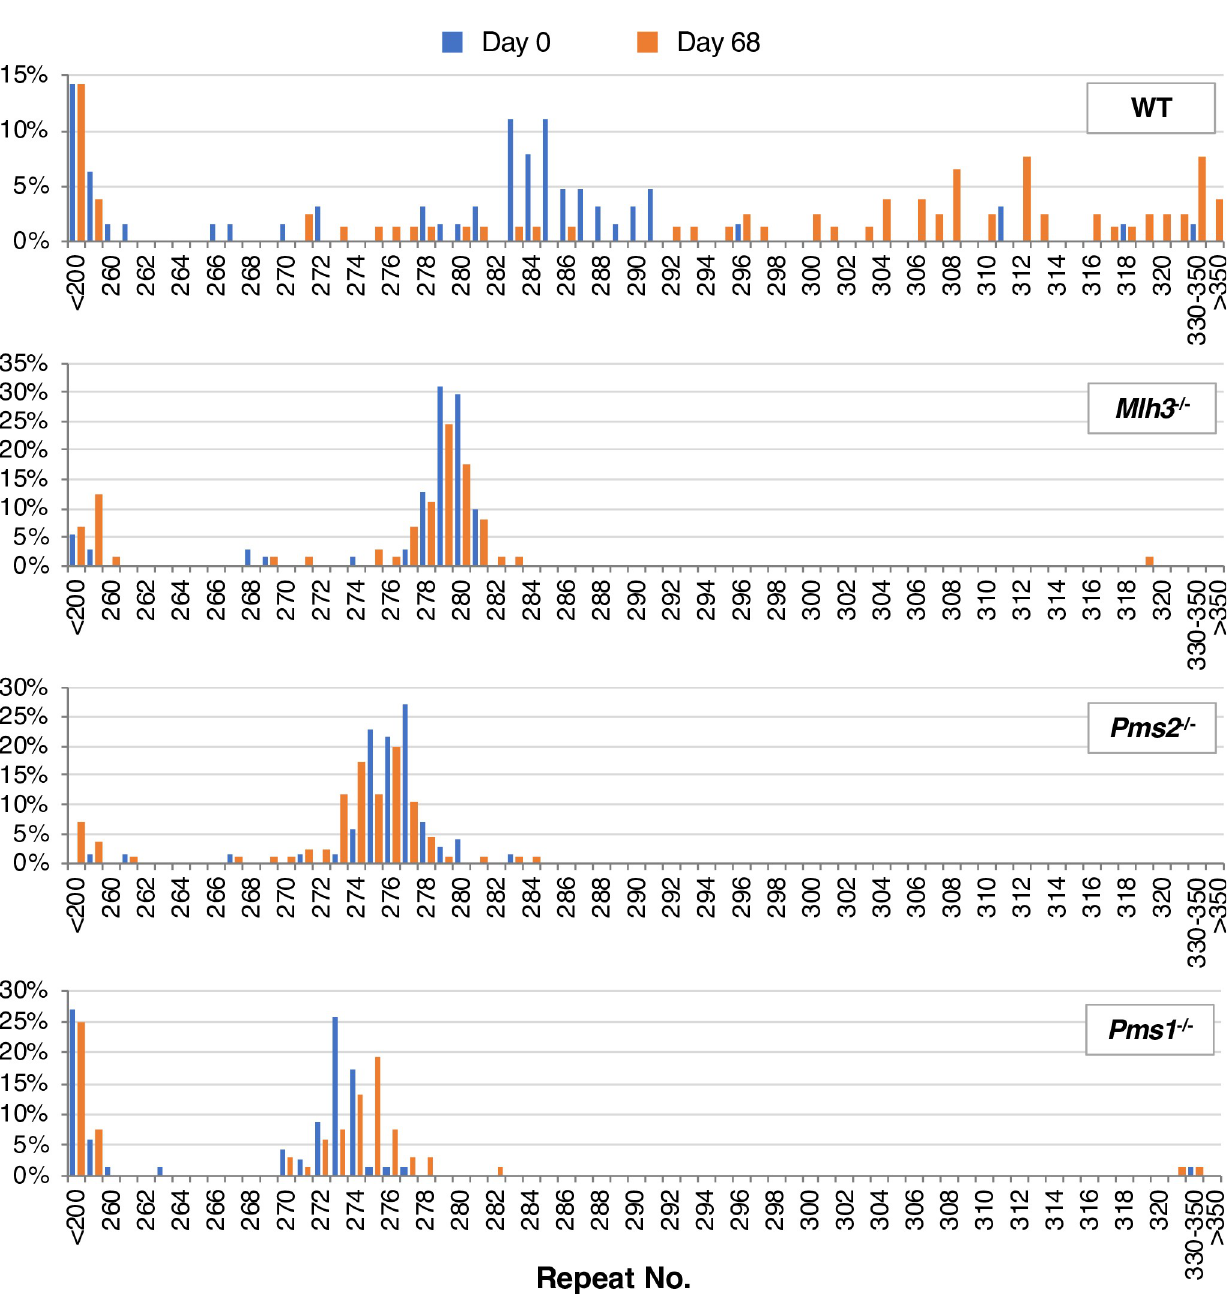
Fig 3. Small Pool PCR analysis of DNA isolated from WT, Mlh3 -/- , Pms2 -/- and Pms1 -/- lines at day 0 and day 68. The day 0 data is shown with the blue bars, the day 68 data with orange bars. One line was used for each genotype (#2 for WT, Mlh3 -/- and Pms1 -/- and #1 for Pms2 -/- ) and 68–86 alleles were assessed for each line. Note that the nested PCR required for SP-PCR results in a left shift of the modal repeat number by two repeats relative to the number seen in the bulk PCR, likely because of additional strand-slippage during the large number of rounds of PCR involved.